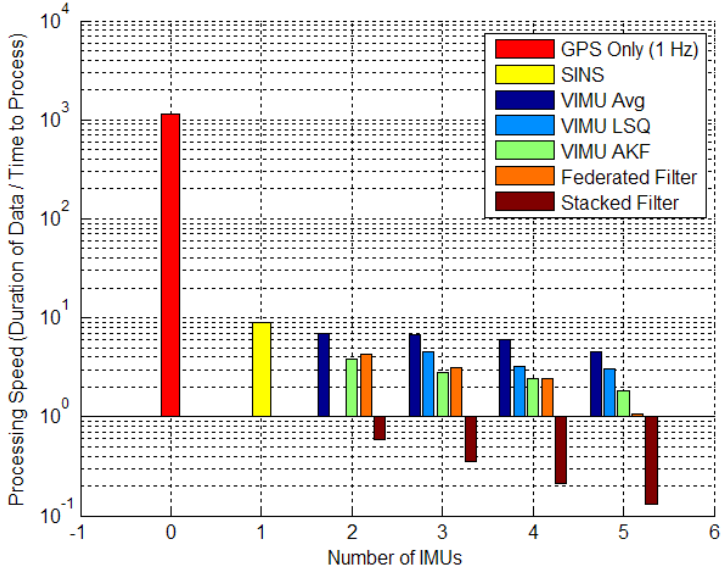
Figure 19. Processing Speed of Various